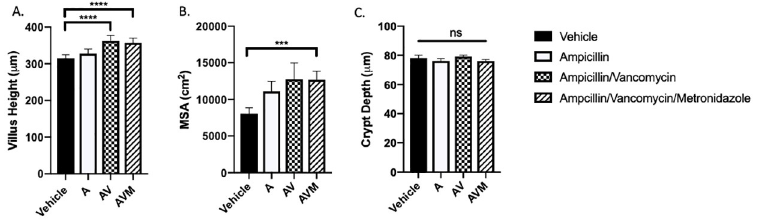
Fig 8. Use of narrower antibiotic regimens. Demonstration of morphometric parameters in CONV mice after 14 days of treatment with either Vehicle, Ampicillin (A), Ampicillin/Vancomycin (AV), or Ampicillin/Vancomycin/ Metronidazole (AVM). (A) Combined villus height is increased in both AV and AVM treated mice. (B) Calculated mucosal surface area (MSA) was increased in AVM treated mice compared to vehicle. (C) No significant (ns) difference was noted in crypt depth between the groups. Values presented as Mean ± SEM; ��� p < 0.001, ���� p < 0.0001; n = 4 CONV mice, n = 4 A mice, n = 4 AV mice, n = 4 AVM mice.